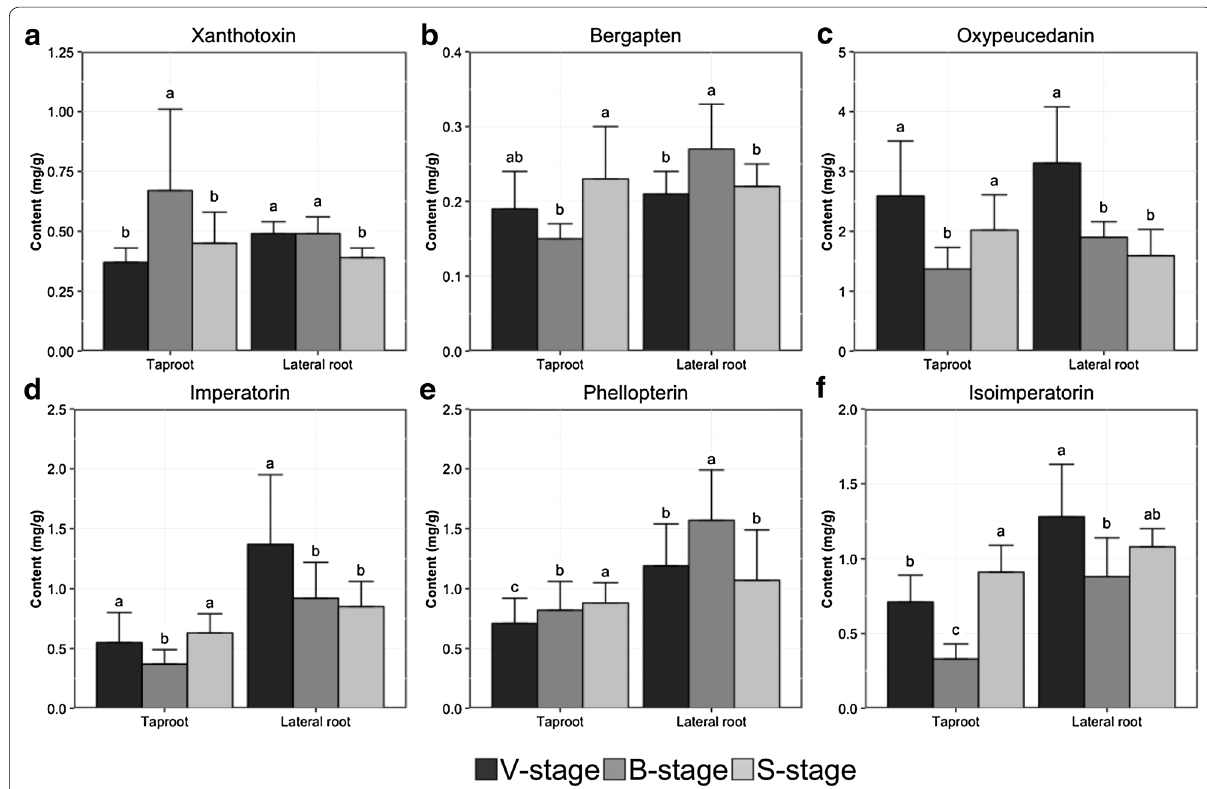
Fig. 5 Xanthotoxin ( a ), bergapten ( b ), oxypeucedanin ( c ), imperatorin ( d ), phelllopterin ( e ) and isoimperatorin ( f ) content in Baizhi taproot and lateral root harvested at three stages. Roots were extracted with methanol and subjected to HPLC‑DAD analysis ( n furanocoumarin content (mg/g sample). Different letters indicate statistical significance (p < 0.05) by LSD